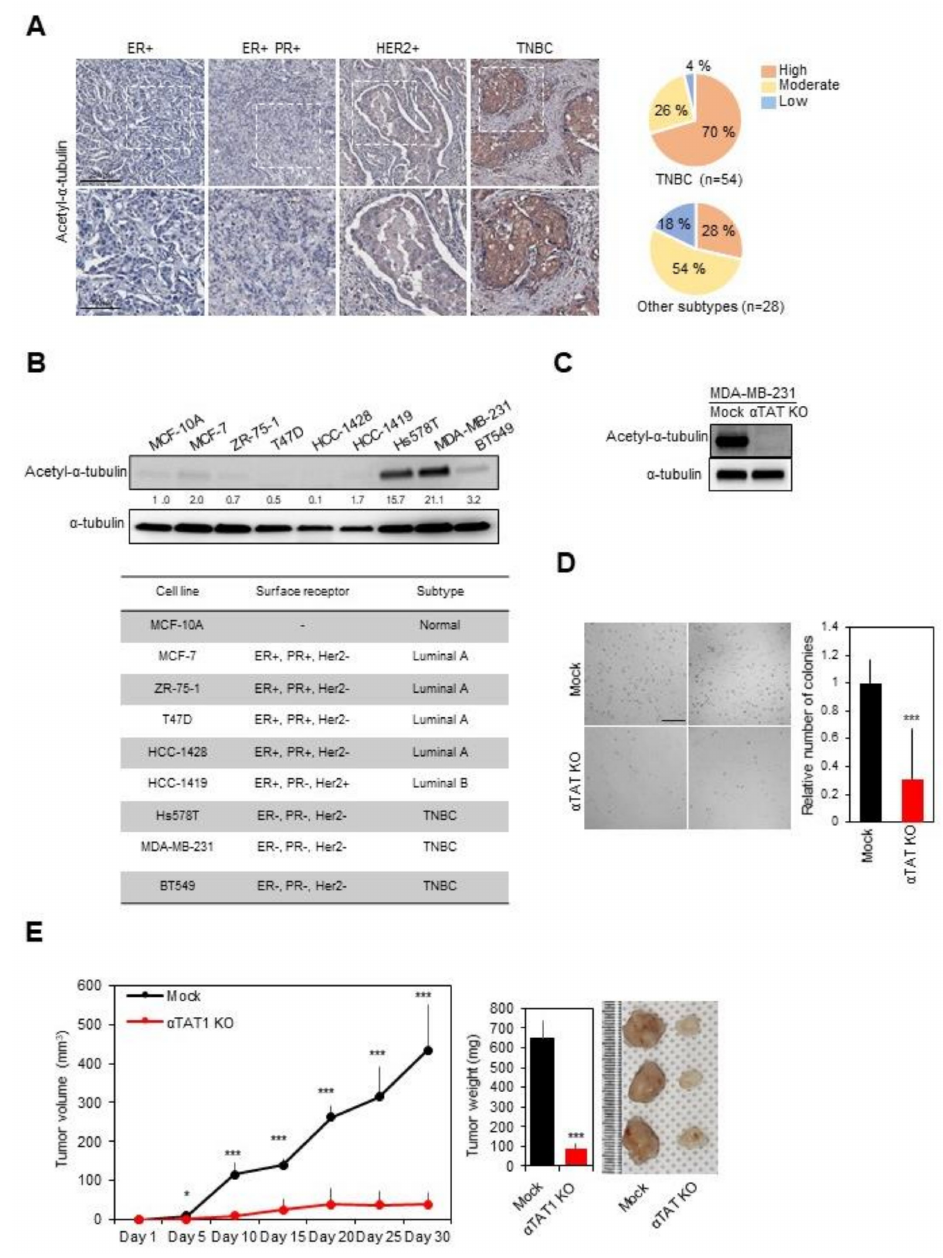
Figure 1. Inhibition of triple-negative breast cancer (TNBC) progression by blocking microtubule acetylation. ( A ) Representative images showing acetyl- α -tubulin expression in various subtypes of human breast cancer. Scale bar, 500 µ m. The intensity was analyzed using Aperio Image Scope software. ( B ) Expression of microtubule acetylation in breast cancer cell lines (upper panel) categorized according to the subtype (lower panel). ( C ) Confirmation of acetyl- α -tubulin expression in alpha-tubulin acetyltransferase 1 ( α TAT1) Knockout (KO) MDA-MB-231 cell lysates. ( D ) Anchorage-independent growth assays using α TAT1 KO MDA-MB-231 cells for 3 weeks. The number of colonies was quantified using ImageJ software. Scale bar, 1 mm. ***, p ≤ 0.001. ( E ) Mock and α TAT1 KO MDA-MB-231 cells were injected into the mammary fat pad of non-obese diabetic / severe combined immunodeficiency (NOD / SCID) mice ( n = 5, each). *, p ≤ 0.05; ***, p ≤